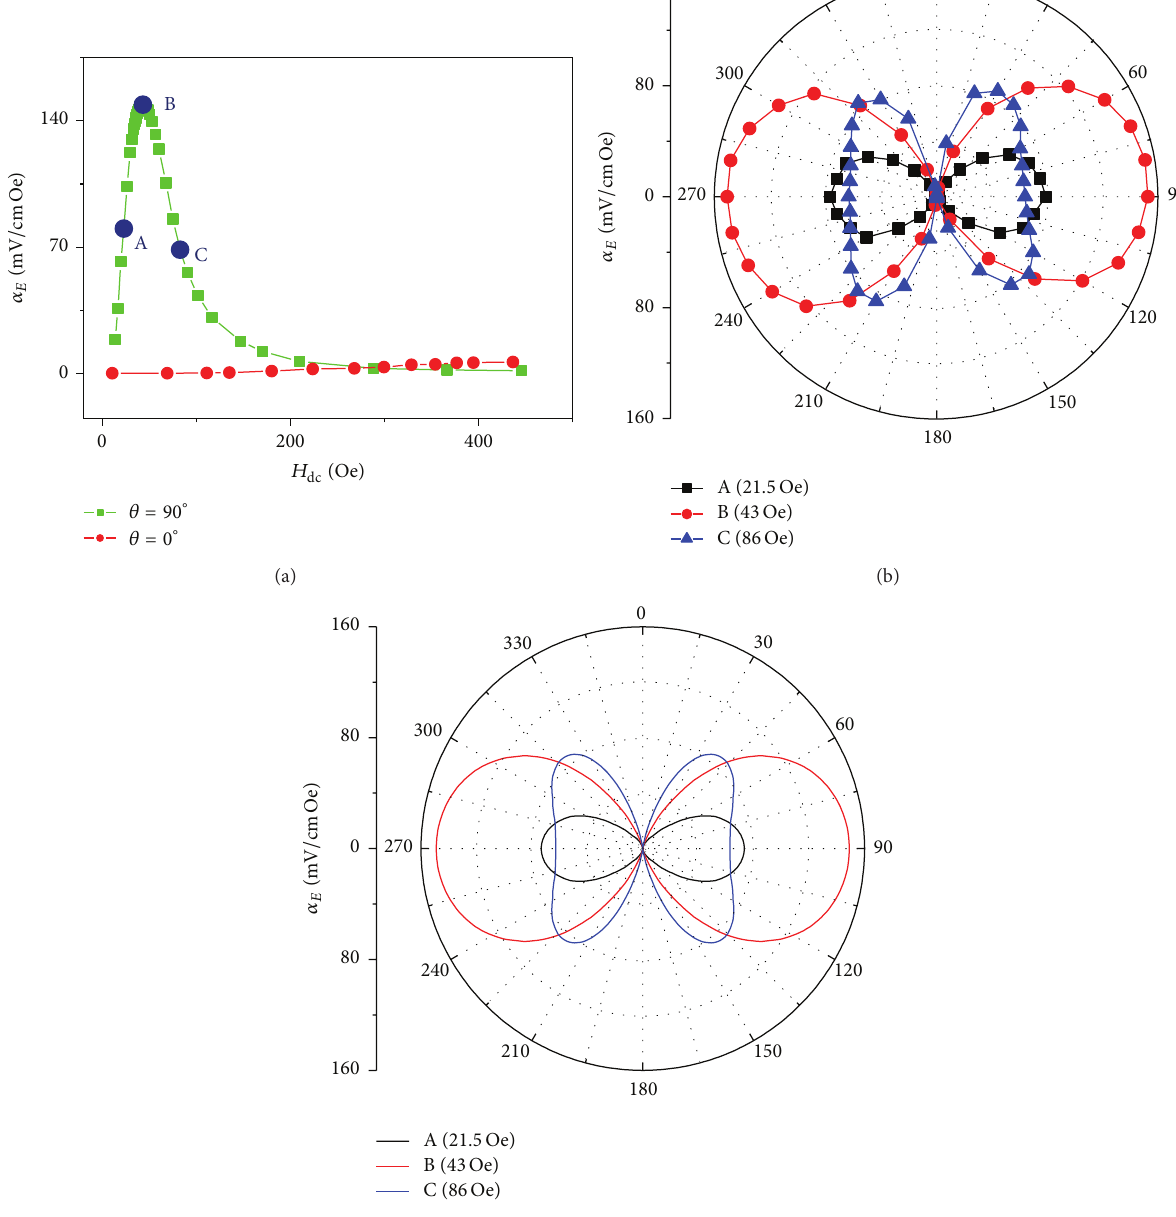
for the PZT slab (Sample 2). (b) Experimentally measured polar plots of the angular dependent ME coefficient 𝛼 𝐸 in Sample 2 and (c) the computer